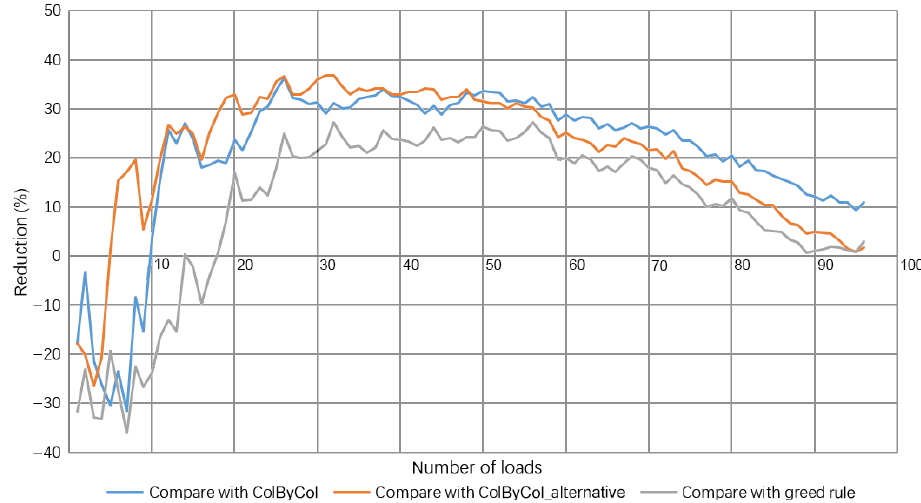
Fig. 13 Makespan of AC algorithm compared with other rules under the six tiers and eight columns